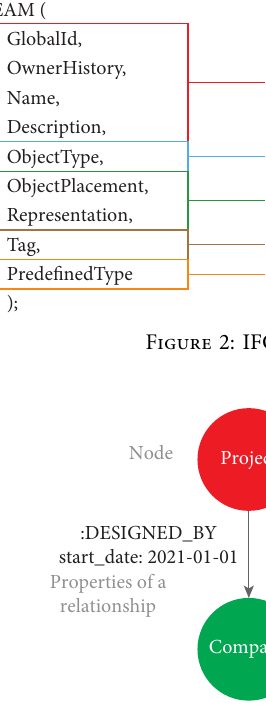
Figure 3: Example of the labelled property